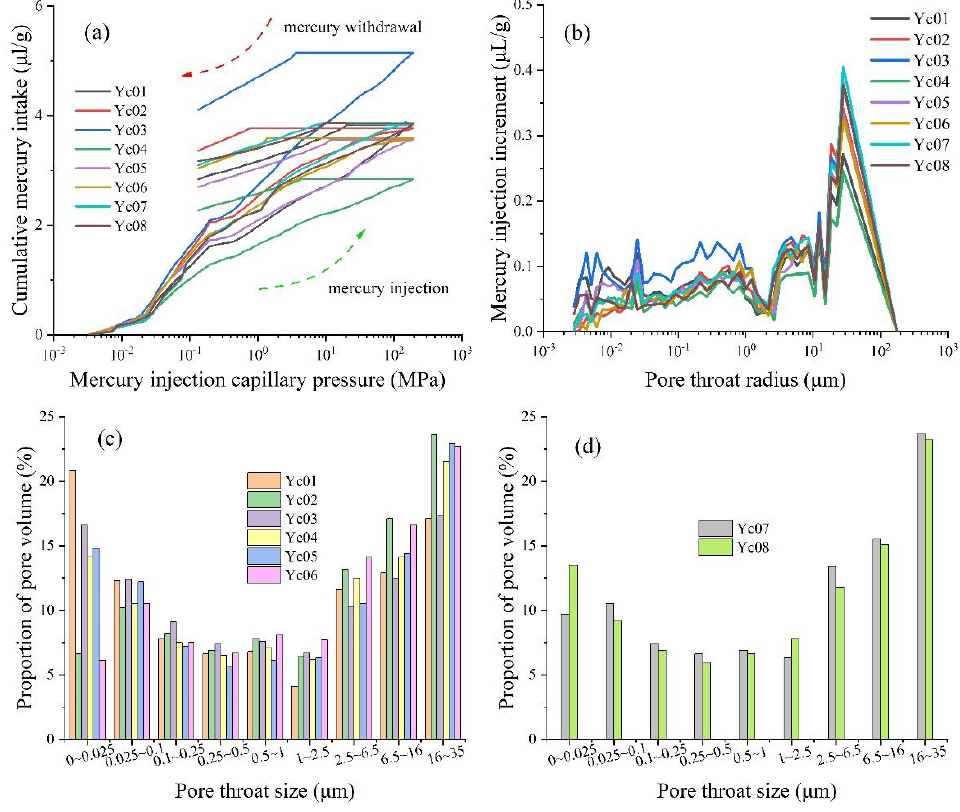
Figure 4. Plots illustrating ( a ) the high-pressure mercury injection responses, ( b ) pore throat radium and ( c , d ) pore size distribution ranges for shales from the WF-LMX